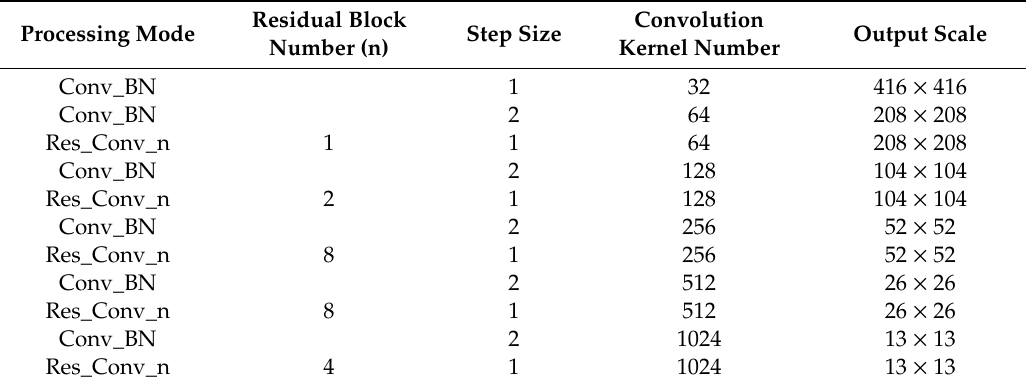
Table 1. The basic parameters of the Darknet-53 network